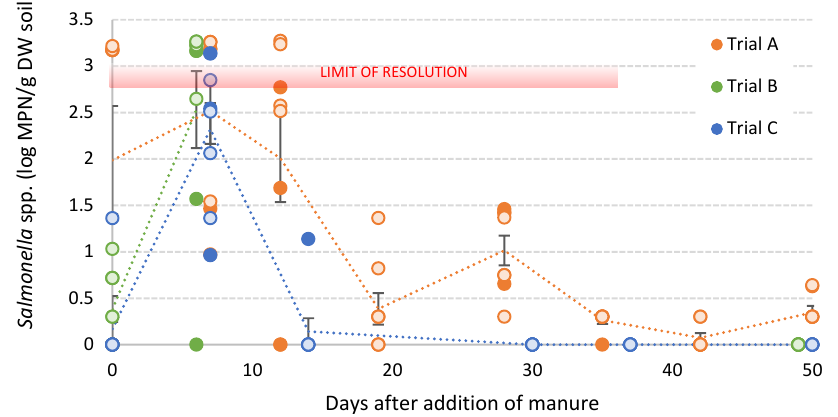
Figure 5. Populations of Salmonella spp. in sandy ( • ) and clay loam ( ) soil amended with poultry litter inoculated with S. sofia (b). Each point represents a test result (4 points/sampling time/soil type/trial). Dashed lines indicate the mean for each dataset; bars indicate the standard error of mean values.